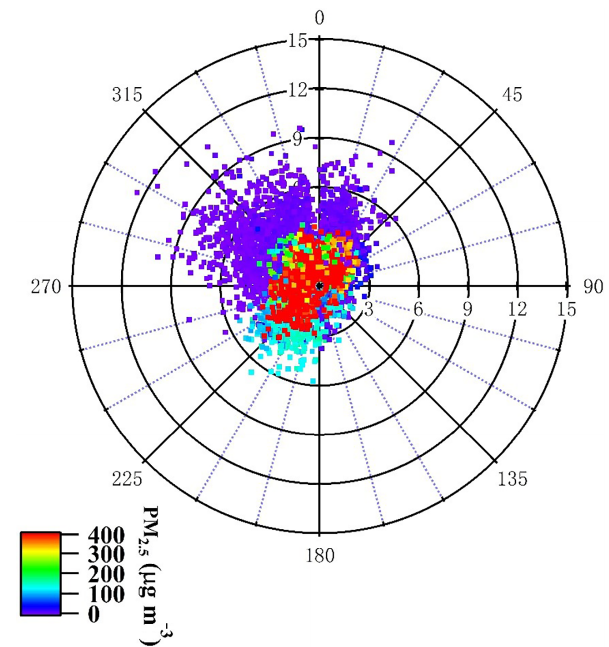
Figure 3. Minutely recorded data for wind direction and wind speed color-coded with respect to PM 2 . 5 mass